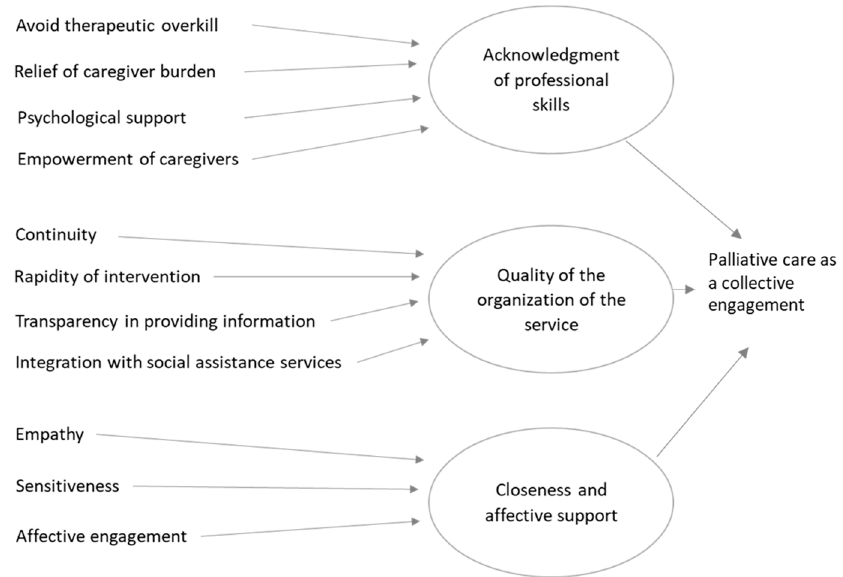
Figure 1. The structure of data collected from the focus groups with caregivers as emerged in our analysis.